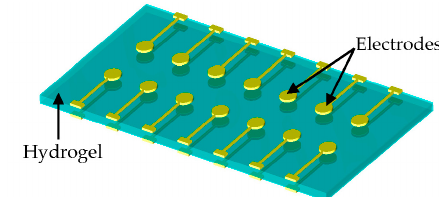
Figure 5. Schematic of the proposed design of hydrogel capacitive pressure sensor array with patterned electrodes on top and bottom surface of